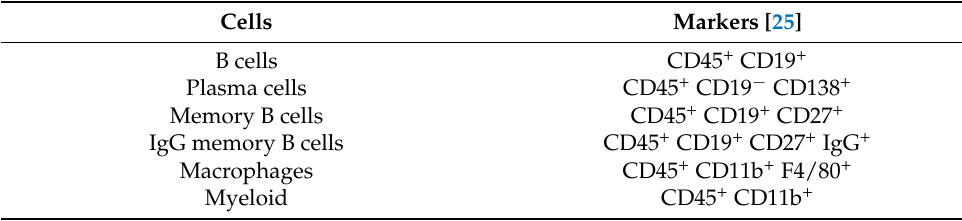
Table 1. Cell-marker schemes for identification of cell populations.